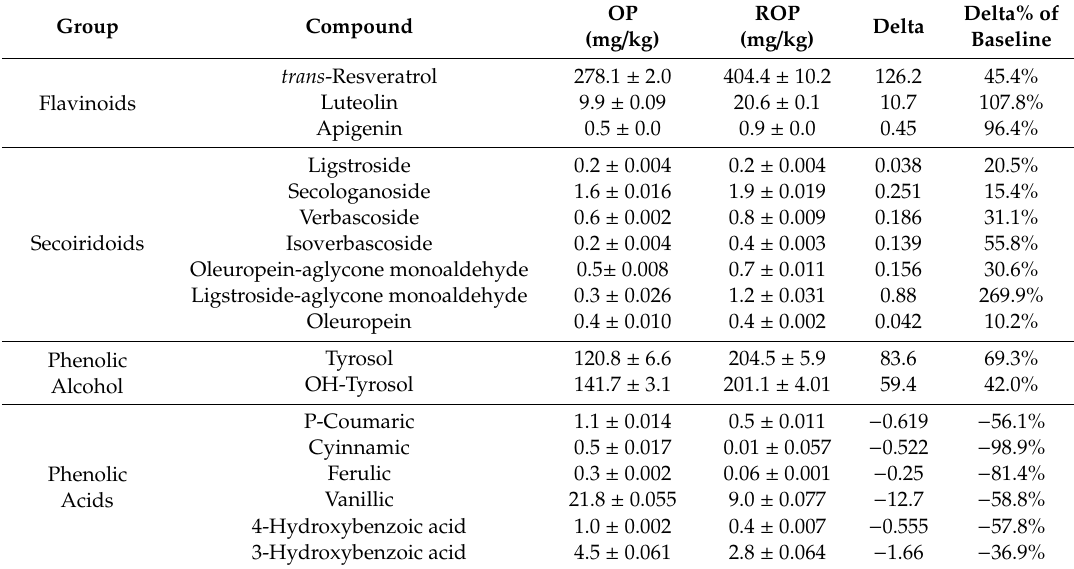
Table 3. Phenolic compounds in OP and ROP.